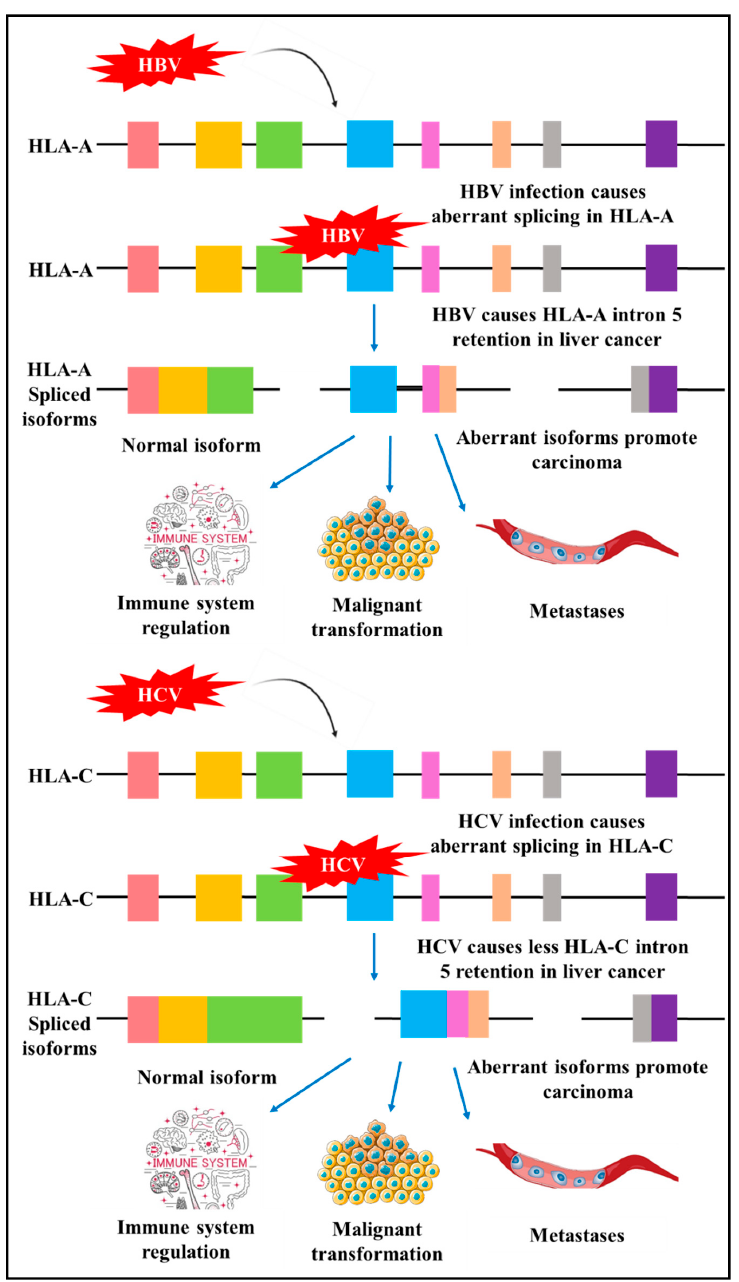
Figure 3. HBV and HCV induced aberrant alternative splicing. HBV disrupts cellular alternative splicing to produce human leukocyte antigen (HLA)-A isoforms with intron five retention compared to HCV. HCV infection leads to infrequent HLA-C intron five retention resulting in malignancy. HLA-A and -C are important in immune surveillance. Coloured boxes: Exons, Black solid line: Introns